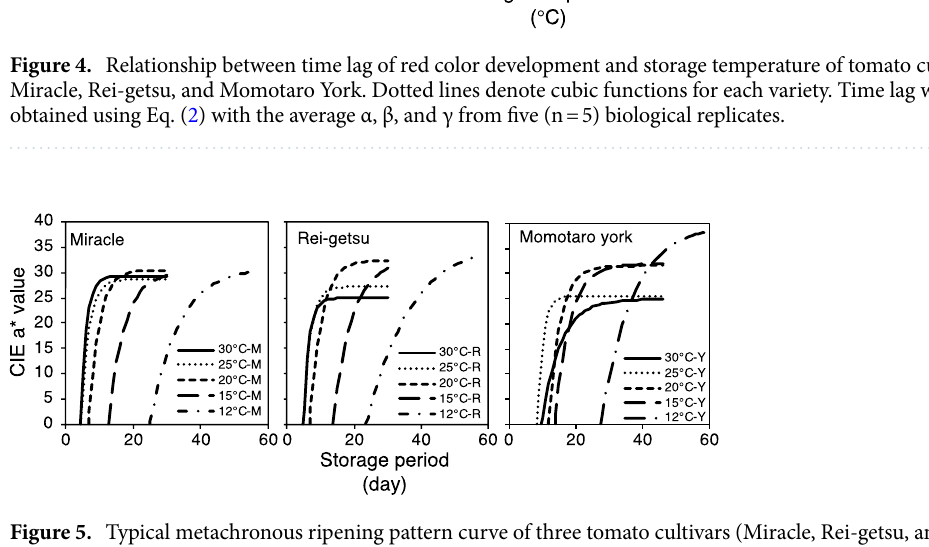
Figure 5. Typical metachronous ripening pattern curve of three tomato cultivars (Miracle, Rei-getsu, and Momotaro York) stored at 12, 15, 20, 25, and 30